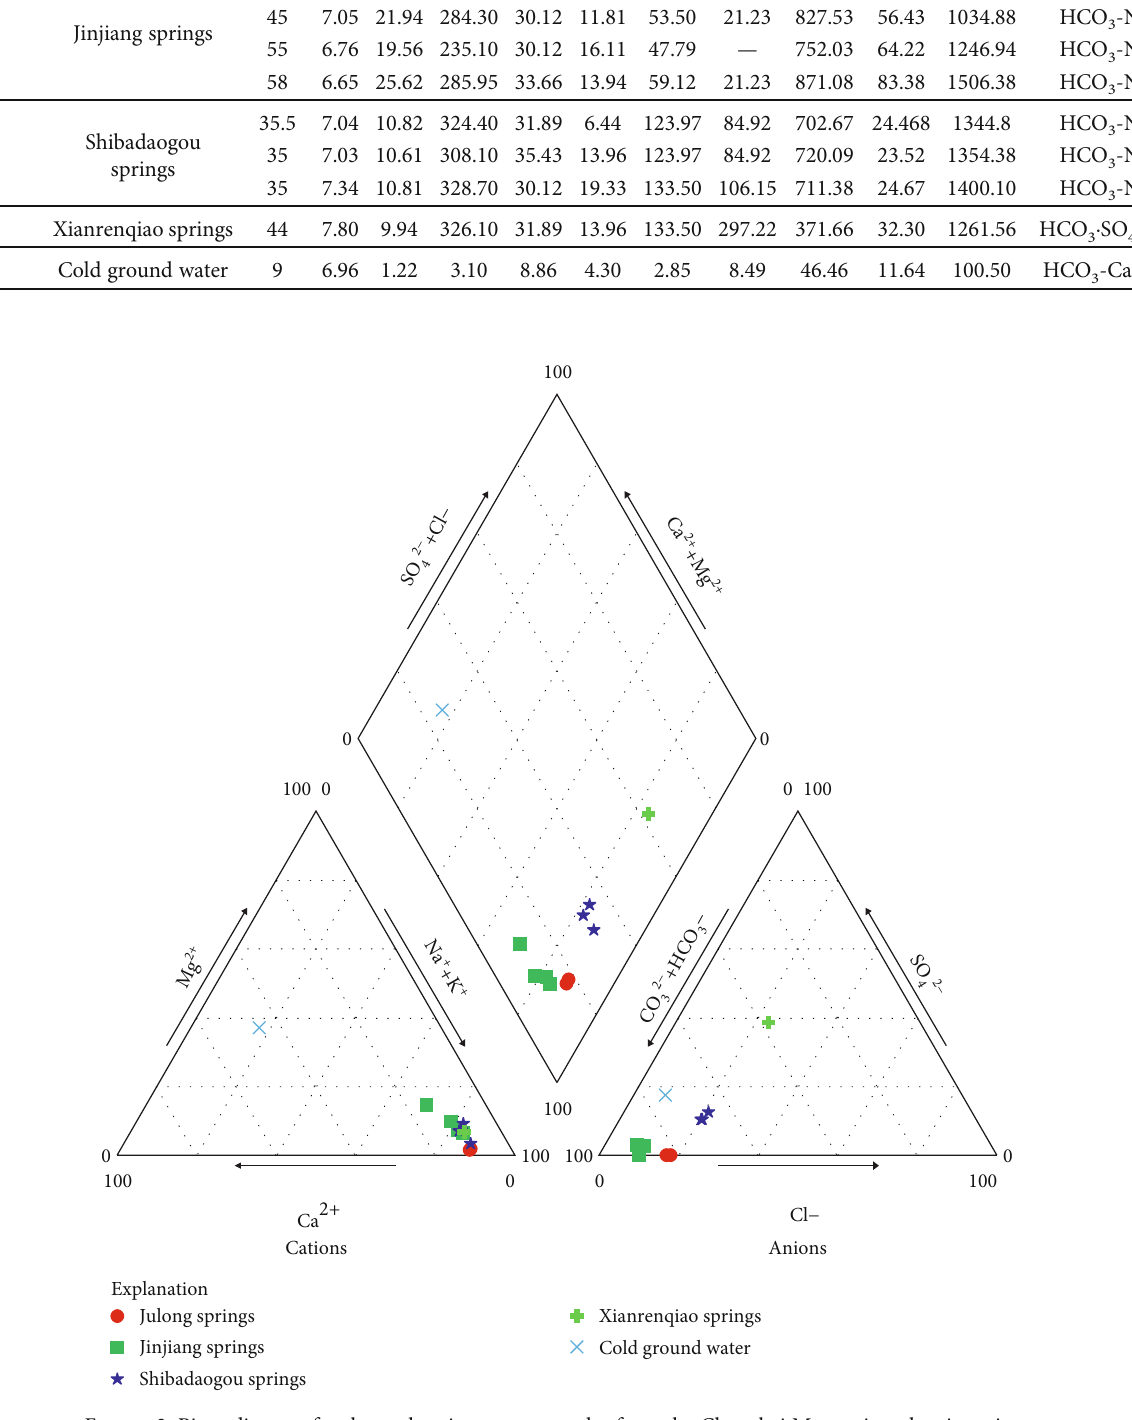
Figure 2: Piper diagram for thermal spring water samples from the Changbai Mountain volcanic